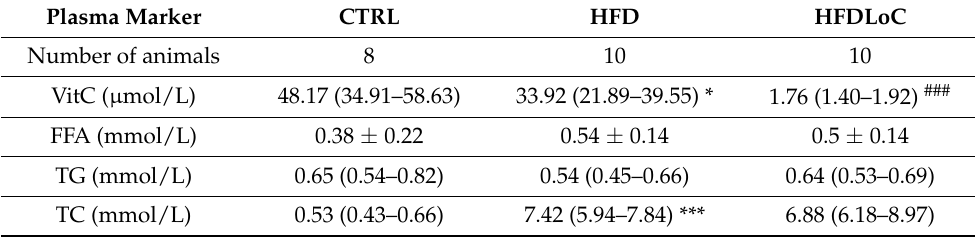
Table 1. Plasma vitamin C concentrations and markers of dyslipidemia in the guinea